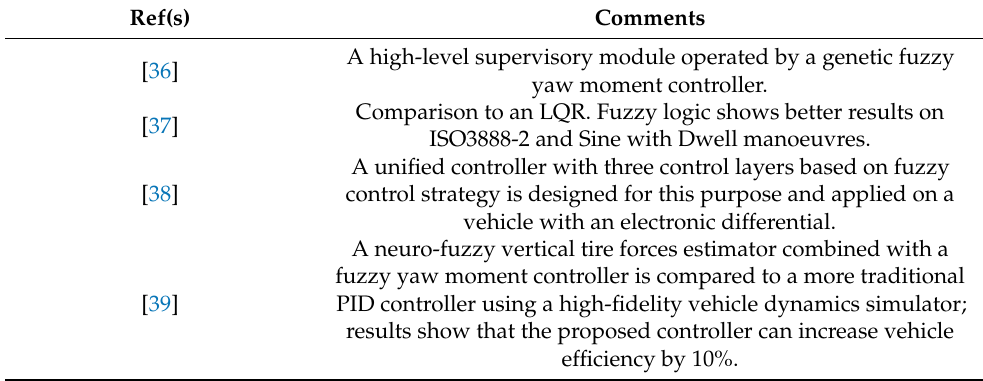
Table 4. Fuzzy controllers applied to DYC.